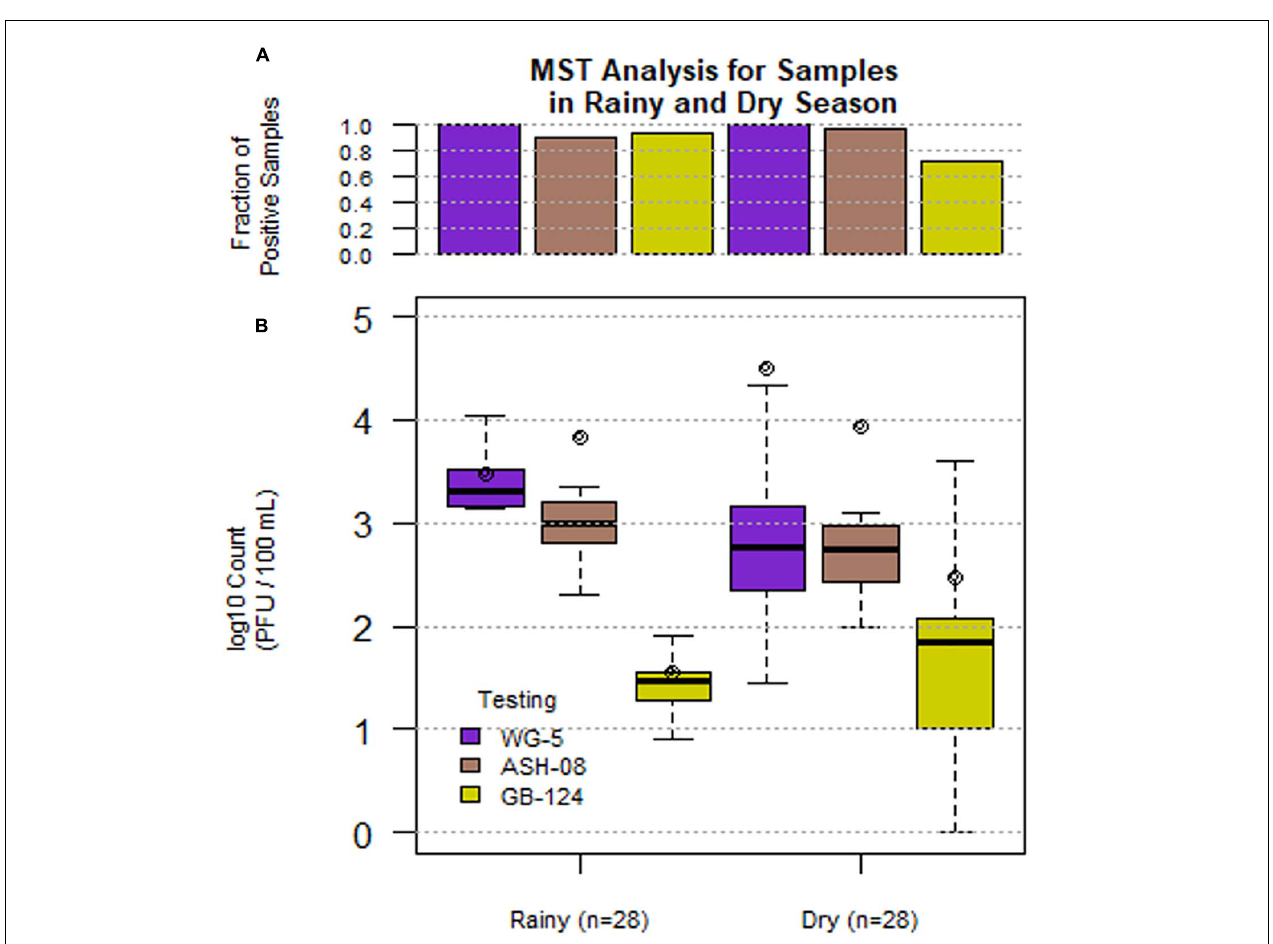
FIGURE 1 | Phage (SOMCPH (WG-5), K. intermedia (ASH-08) and B. fragilis (GB-124)) presence (A) and concentrations (B) in sewage samples ( n = 56) during rainy (July-Aug 2017) and dry season (March-May 2018) from two study neighborhoods in Kolkata.